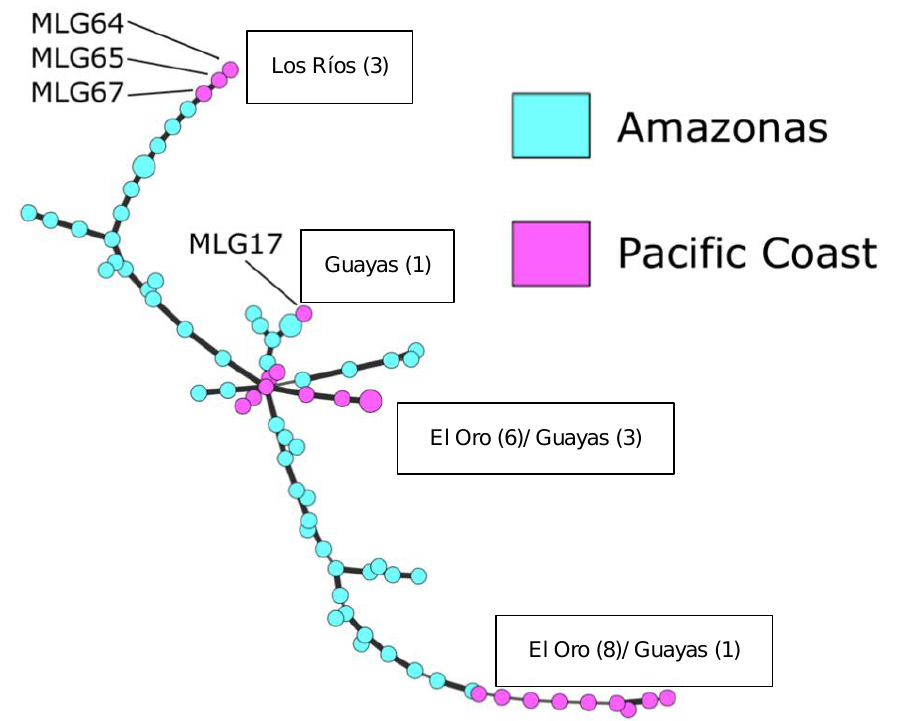
Figure 6. Minimum spanning networks (MSN) showing relationships between the individual multi- locus genotypes (MLGs) observed in the Ecuadorian M. roreri populations from the Amazon and the coast regions. The size of the circles is proportional to the number of individuals with the same haplotype (normally one but in three cases two), and the thickness of the lines represents the Euclidean genetic distance between two nodes (thicker lines mean larger genetic distance).